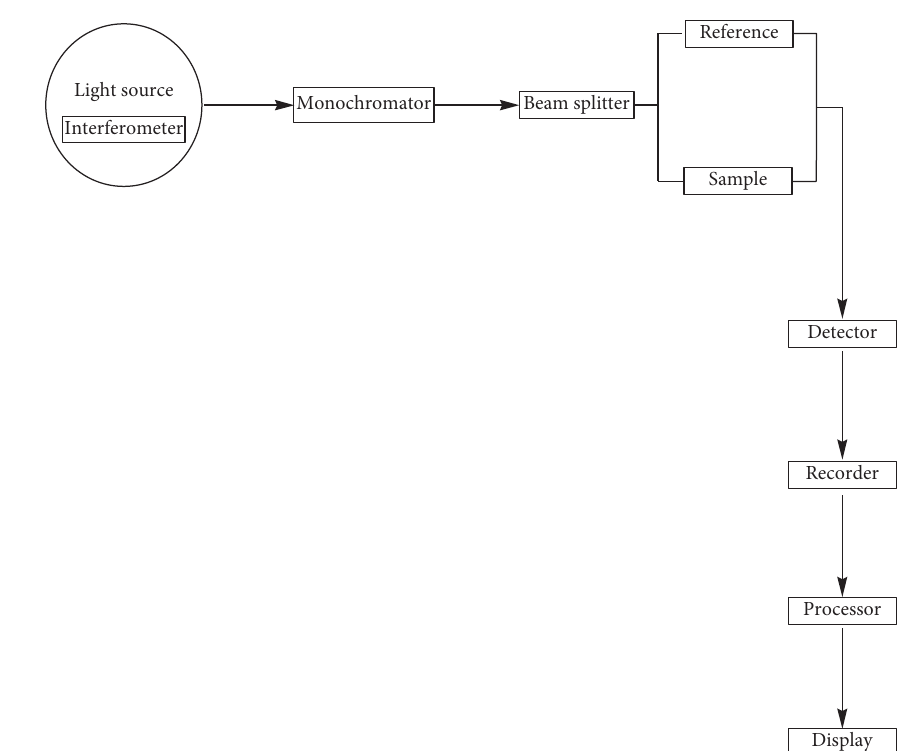
Figure 2: Schematic diagram of IR spectrometer with a two-beam